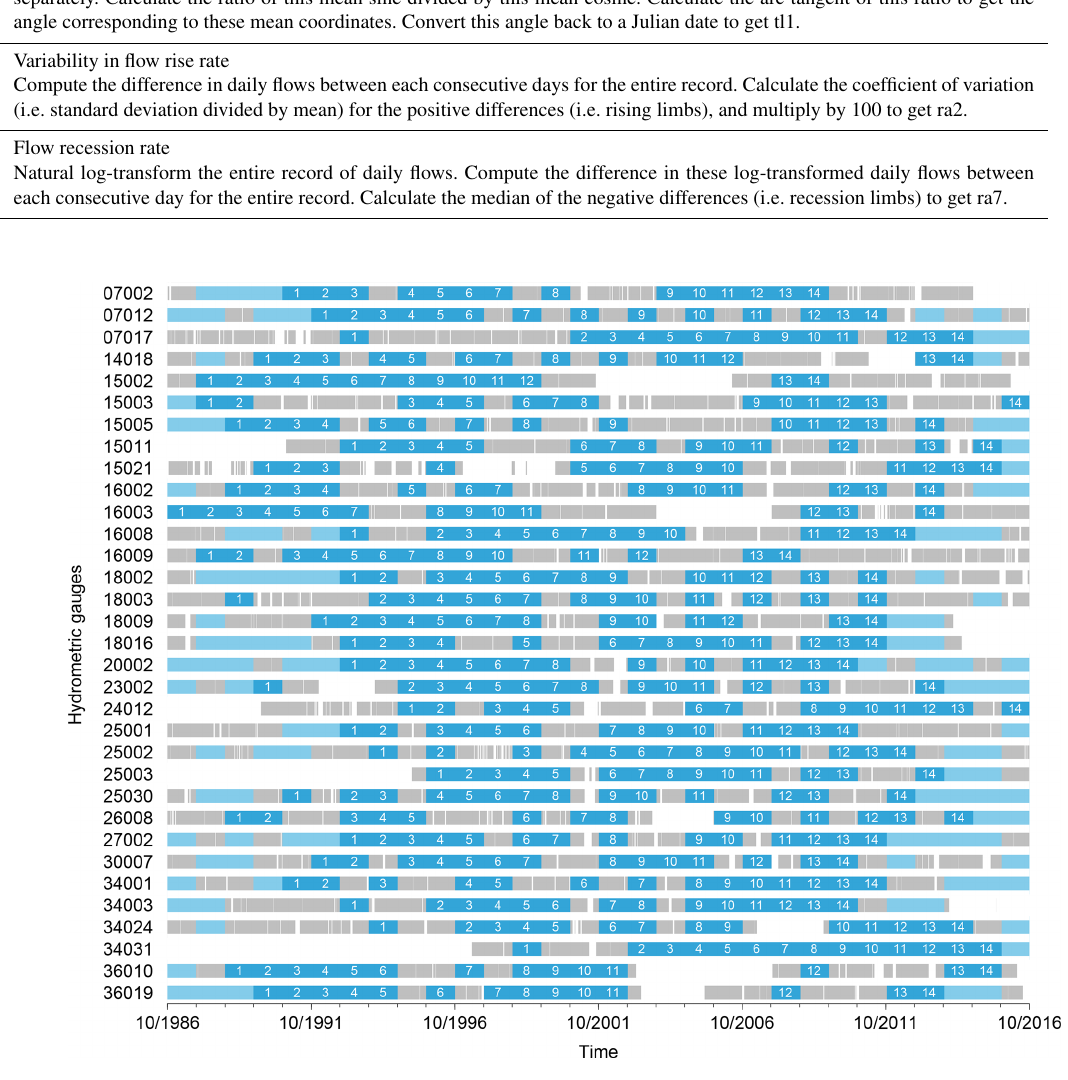
Figure A1. Discharge data availability for the 33 study catchments. The 14 complete hydrological years selected are represented in dark blue and annotated from 1 to 14. Years in light blue are other complete hydrological years that are not retained. Grey years with missing data are represented as bars with